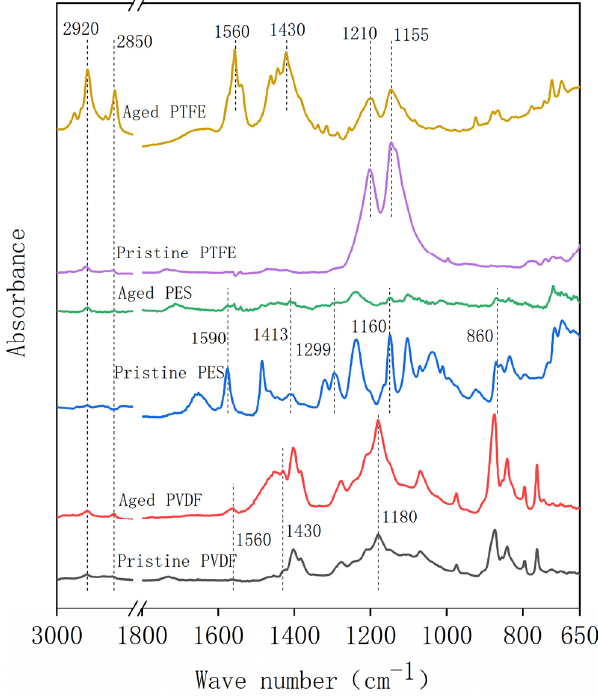
Figure 8. The FTIR of pristine and aged (five-years equivalent) membranes in the alkaline oxide aging test.